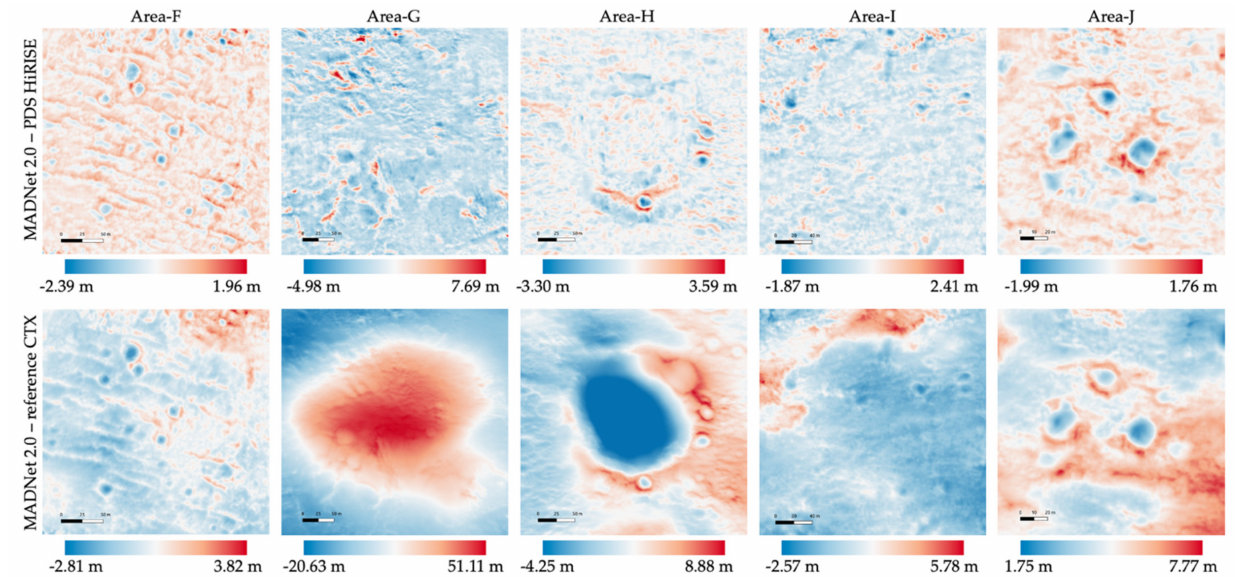
Figure 26. DTM difference maps of the five exemplar areas (i.e., area-F, -G, -H, -I, -J; extents are slightly different due to re-cropping). 1st row: difference maps between the MADNet 2.0 HiRISE DTMs and the PDS HiRISE DTMs; 2nd row: difference maps between the MADNet 2.0 HiRISE DTMs and reference CTX